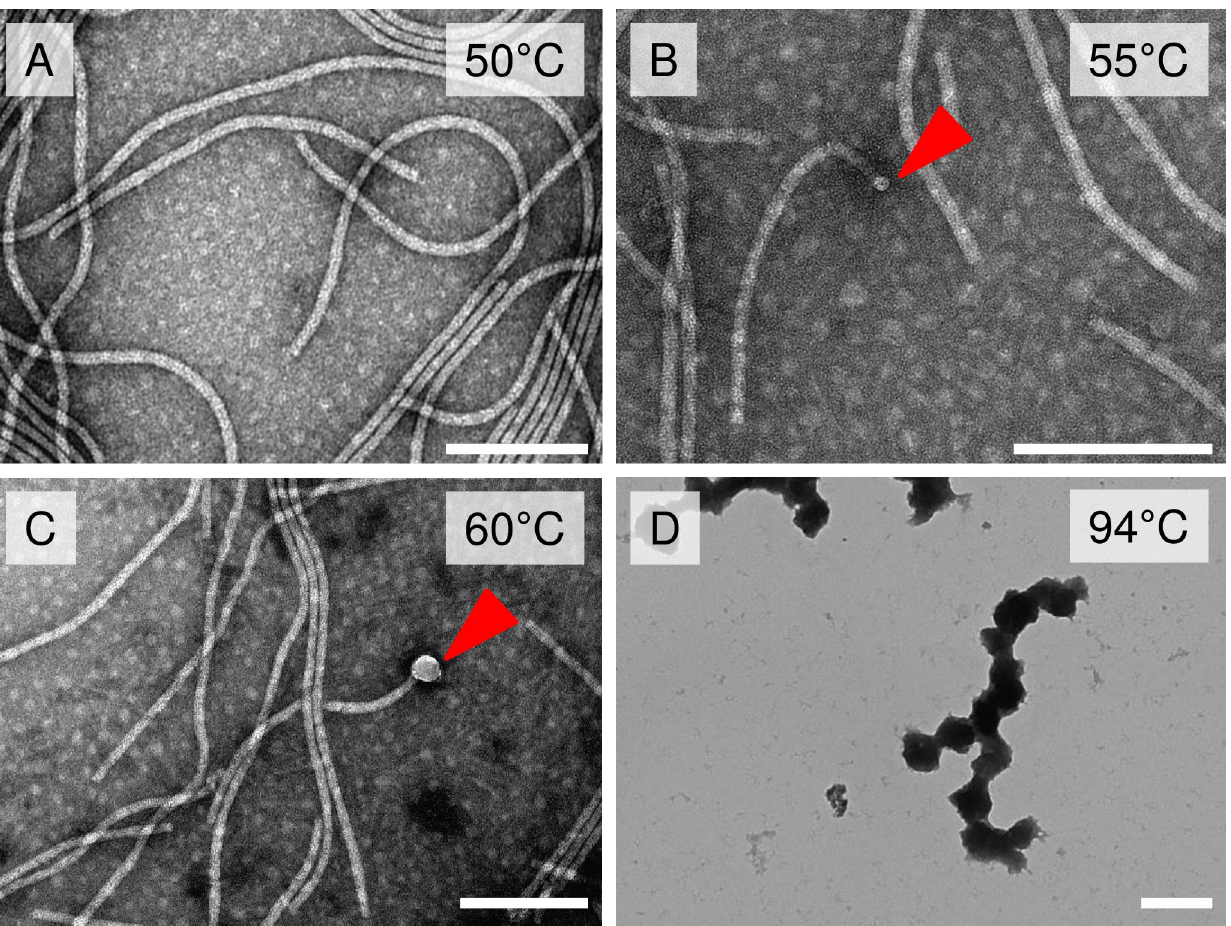
Fig 1. The stages of thermal transition during the formation of SP from AltMV virions. A) AltMV virions after thermal treatment at 50˚C; B) intermediate form, thermal treatment at 55˚C; C) intermediate form, thermal treatment at 60˚C; D) SP V formed after thermal treatment at 94˚C. Transmission electron microscopy, staining with 2% uranyl acetate. Arrows indicate the swelling at the end of the virion (intermediate form). Thermal treatment was carried out for 10 sec. Bars are 200 nm in A, B, C; bar is 400 nm in D.